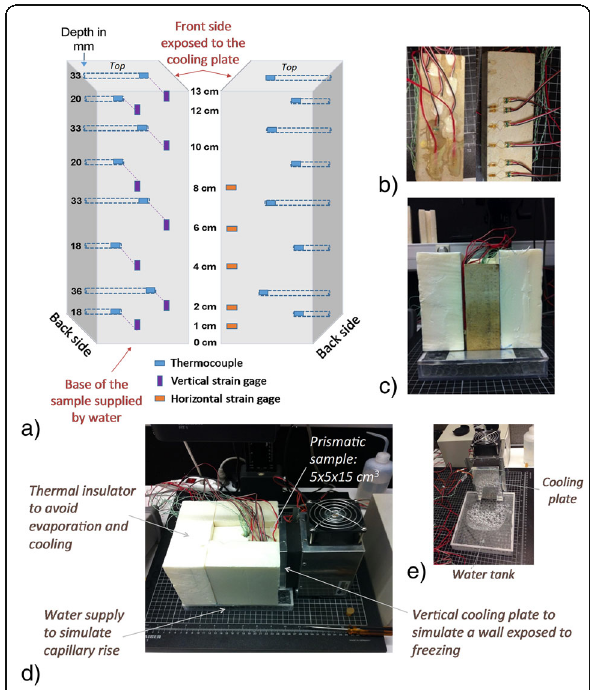
Fig. 3 a Diagram of the setting of strain gages and thermocouples on the sample, b view of the horizontal and vertical strain gages, c lateral view of the face in contact with the cooling plate, and d , e setting of the unidirectional and vertical frost experiment with water